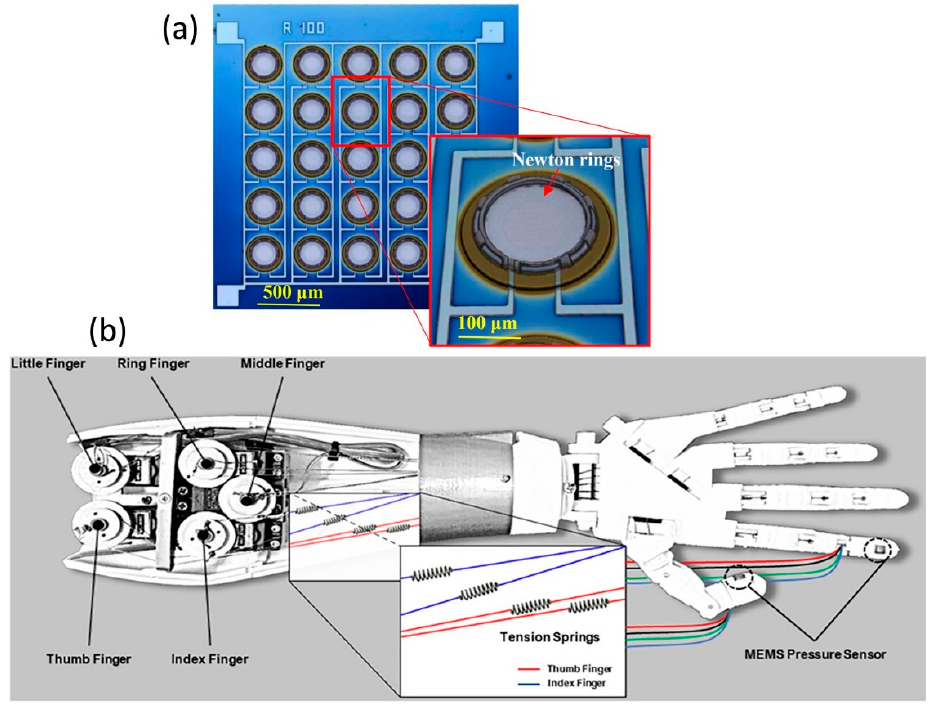
Figure 8. ( a ) Microscopic image of MEMS pressure sensor. Inset: 3D image of a diaphragm with interference patterns (Newton rings), indicating complete sealing. Reprinted/adapted with permission from Ref. [66]. Copyright 2015, IEEE. ( b ) A 3D printed robotic hand with actuation mechanisms. Small capacitive MEMS pressure sensors shown in ( a ) are ideal for the fingertips of the hand. Reprinted/adapted with permission from Ref. [67]. Copyright 2019, SAGE Publishing.